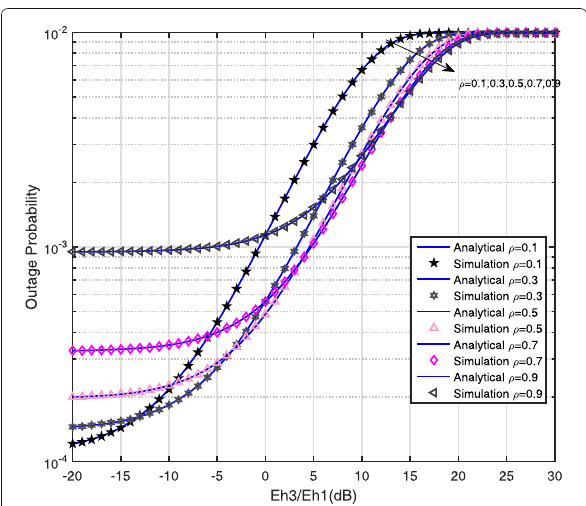
Fig. 4 Outage probability versus d with DF and AF